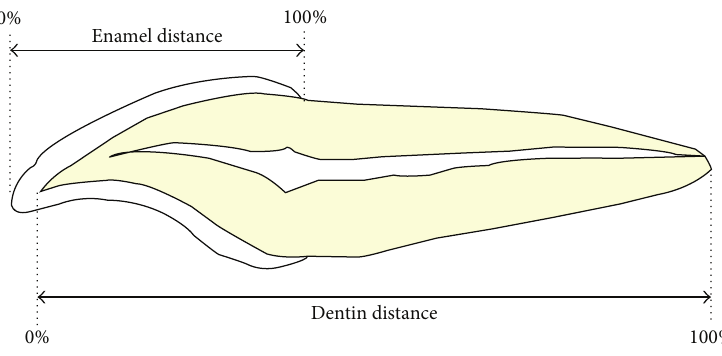
Figure 3: Schematic representation of enamel and dentin distance.